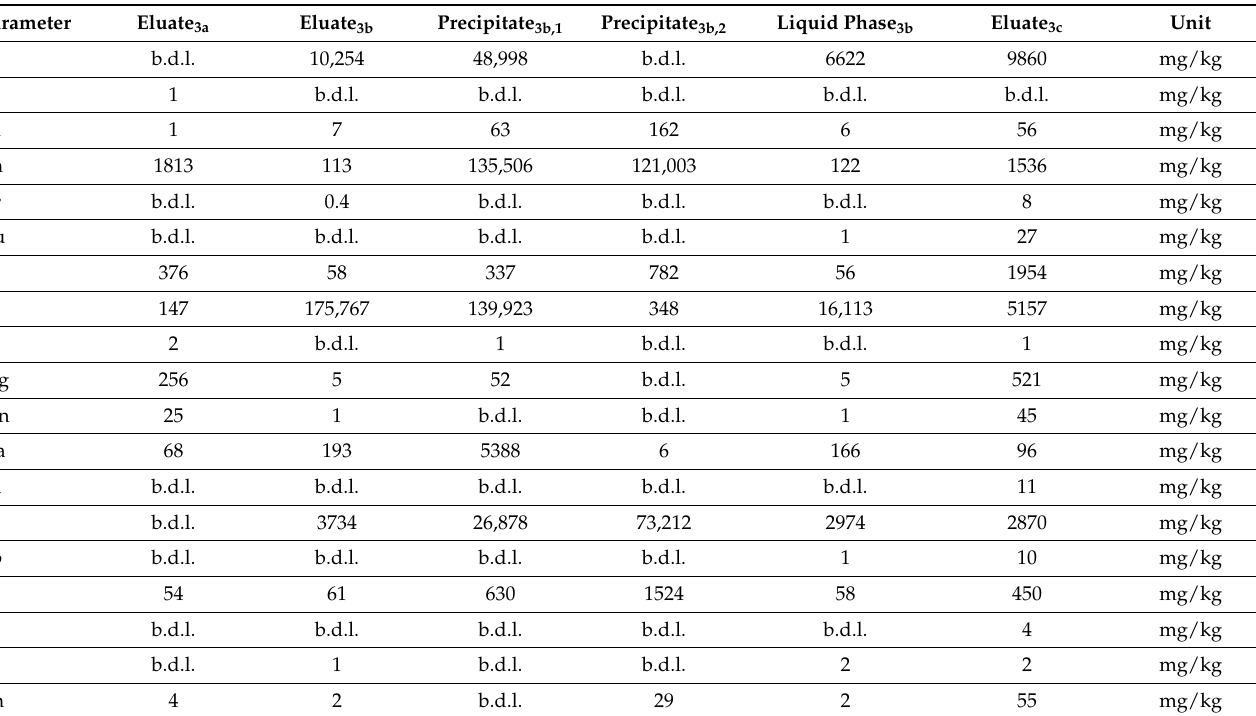
Table 14. Characterization of case 3 inorganic products from step a (eluate 3a ), step b (eluate 3b